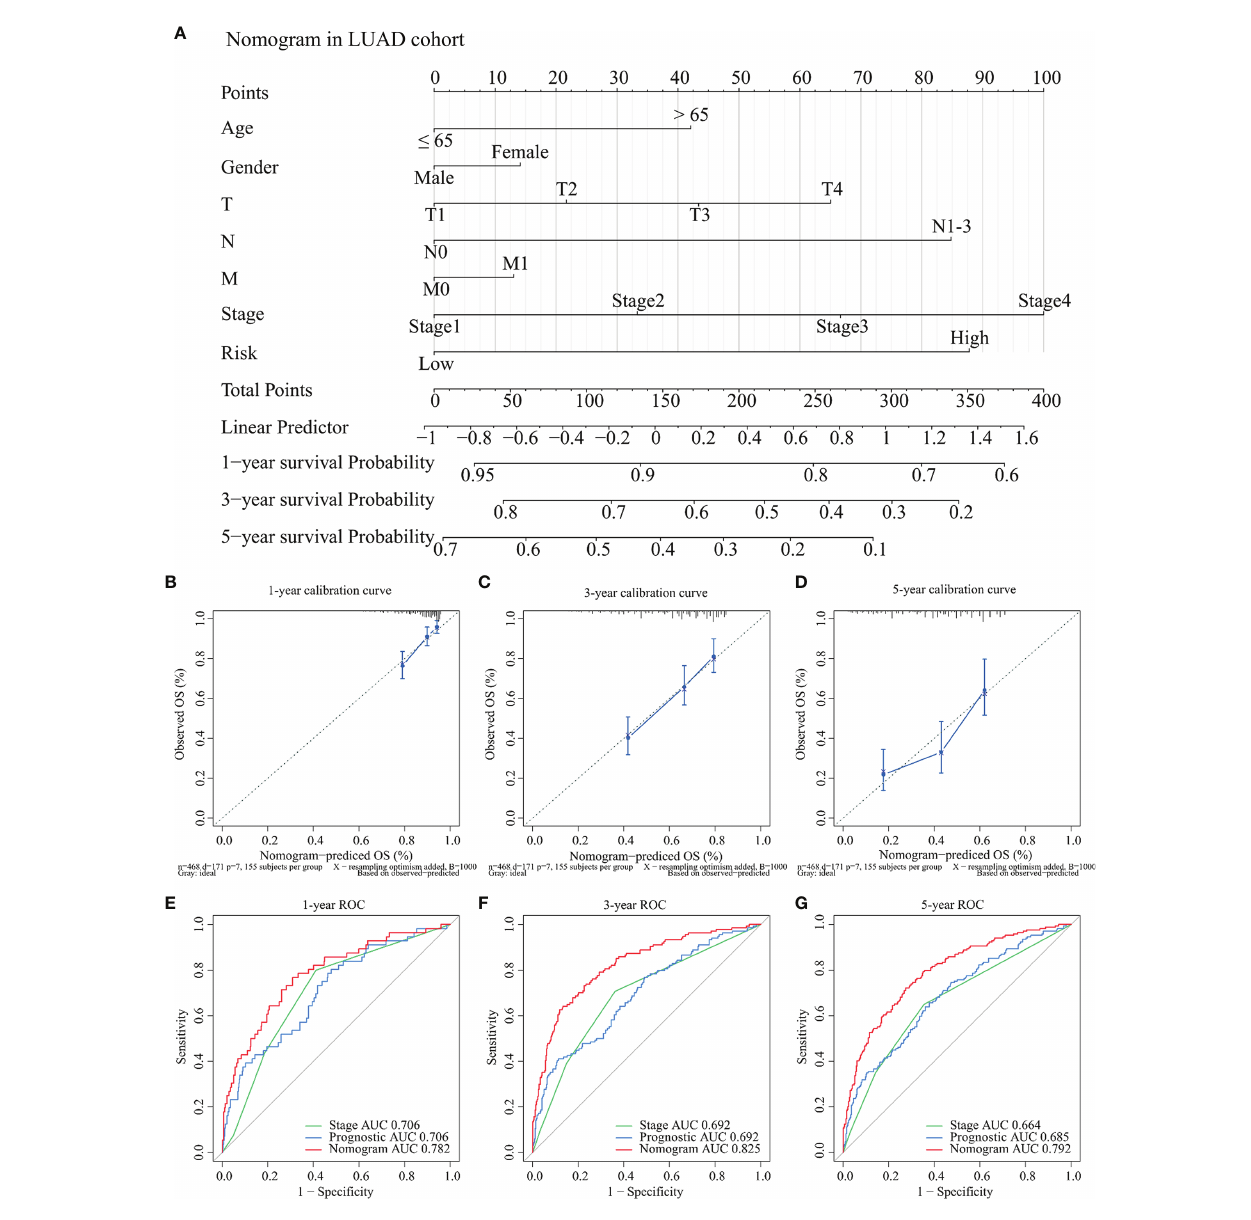
FIGURE 9 | Development and evaluation of the nomogram for OS among TCGA-LUAD patients. (A) A nomogram was established for predicting the OS at 1 year, 3 years, and 5 years by weighting age, gender, T, N, M, stage, and risk score, respectively. (B – D) Calibration curves about the nomogram in 1 year (B) , 3 years (C) , and 5 years (D) . The x -axis represents predicting OS outcome and the y -axis represents actual OS outcome. (E – G) Comparison of ROC curves between stage, risk score, and nomogram at 1 year (E) , 3 years (F) , and 5 years (G) , respectively. OS: overall survival; TCGA: The Cancer Genome Atlas; LUAD: lung adenocarcinoma; ROC: receiver operating